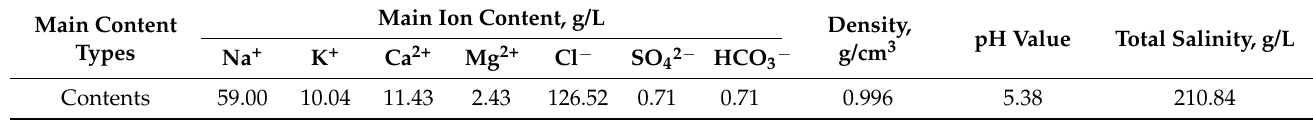
Table 4. Ion contents and total salinity of the simulated formation water.